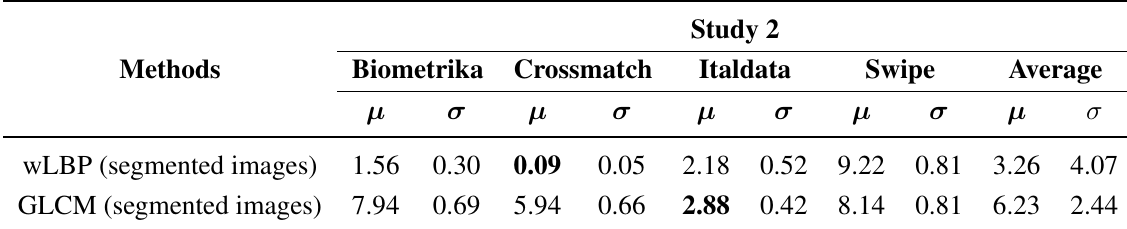
Table 8. ACER for Each Dataset and Their Average, Study 2 (ACER and average in % ).